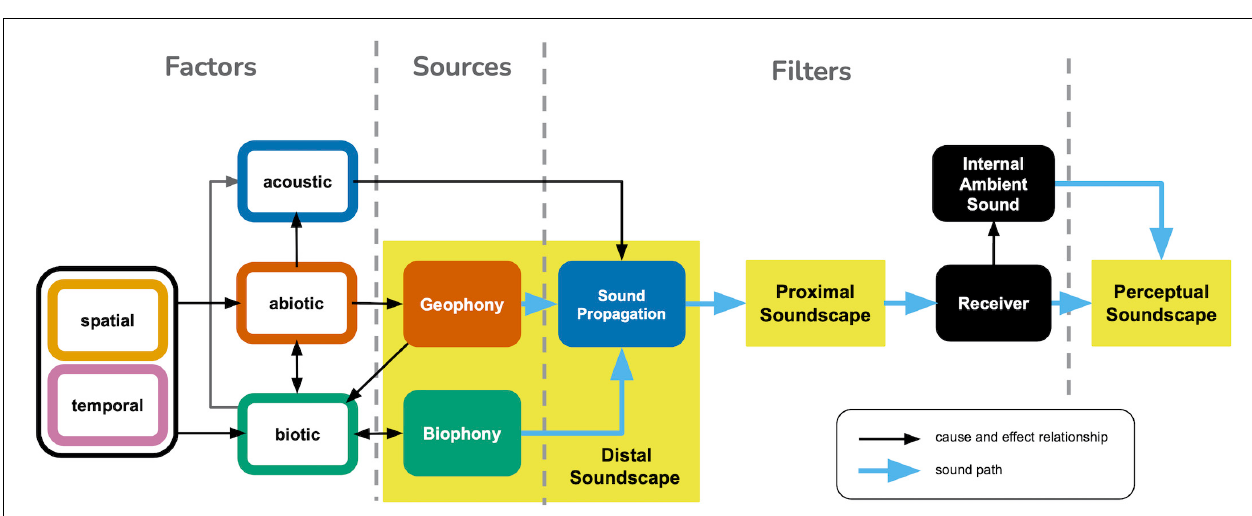
FIGURE 5 | General soundscape functional block diagram. The distal soundscape is closer to environmental factors and their influence on sound production and propagation. The proximal soundscape is located just before the receiver and represents an ideal point of observation which includes external ambient sounds. The perceptual soundscape is the soundscape representation that the receiver progressively builds through its psychoacoustic apparatus. Compared to Figure 1 , the “internal ambient sound” block was added in order to clarify the perceptual soundscape